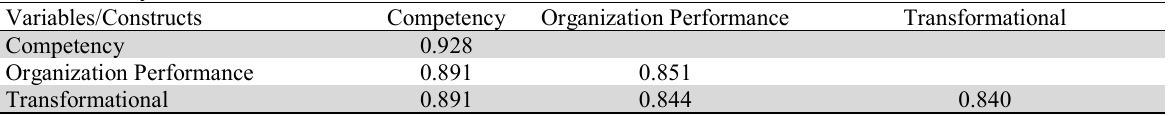
The Summary Result of Fornel-Lacker Criterion Variables/Constructs